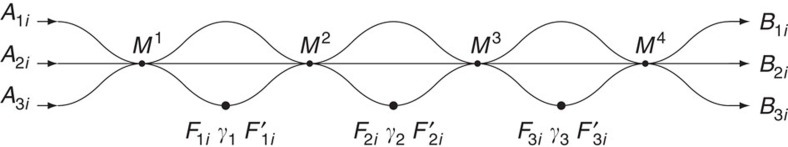
An implementation of the Fredkin gate where feedbacks are eliminated.This design uses four coupling nodes. All nodes couple three channels. Three channels are used for nonlinear manipulation and denoted by F and F′. Each F is then manipulated with an appropriate nonlinear element denoted by γ, which transforms it to F′. The column index i represents different states.